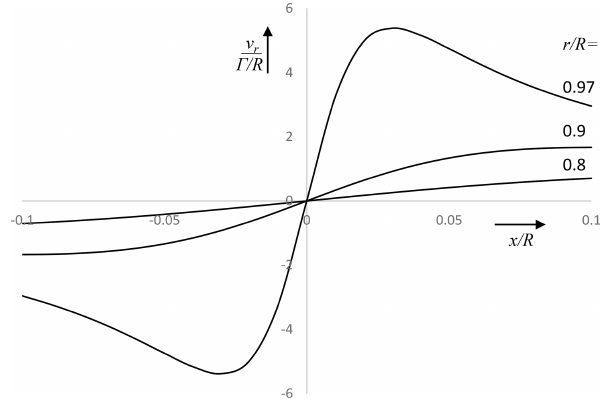
Figure 6. The radial velocity induced by a unit vortex ring posi- tioned at x = 0 , R = 1, at the lines r/R = 0 . 8 , 0 . 9 , 0 .